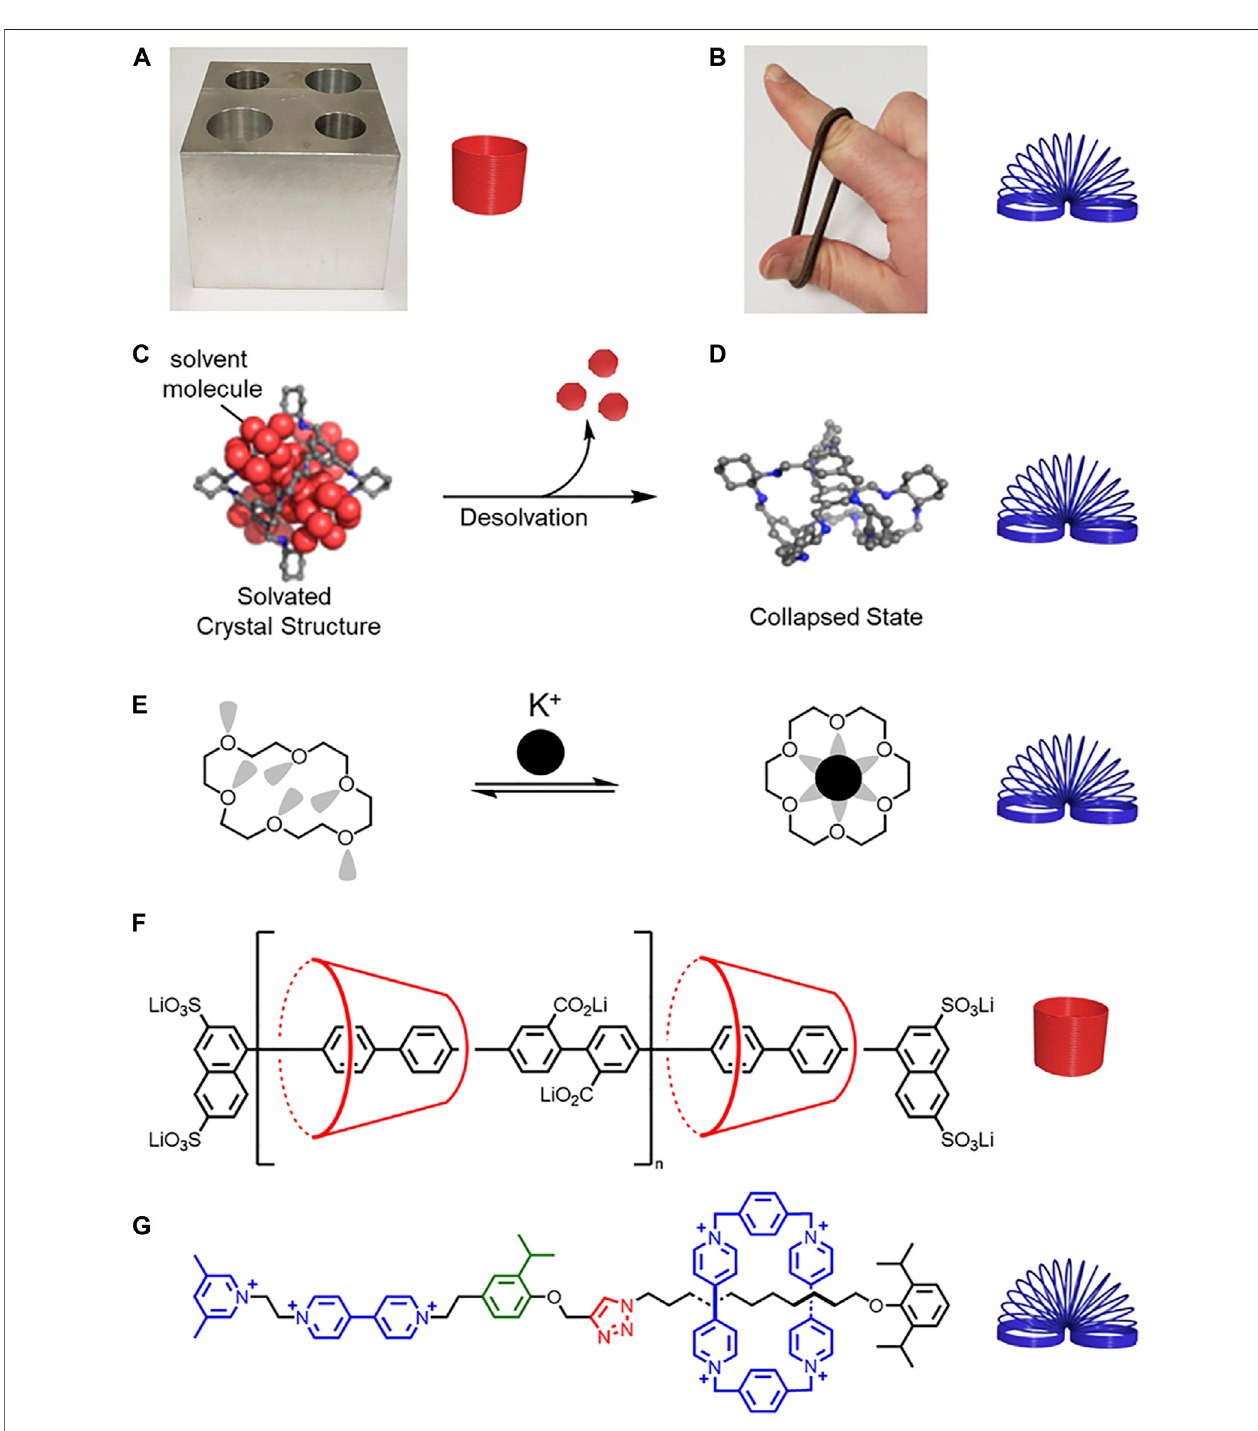
FIGURE 1 | (A) Hard metal block and rigid spring. (B) Soft rubber band and fl exible spring. (C) Schematic representation of a solvated molecular cage (D) collapsing upon desolvation. Adapted with permission from Ref. (Liu et al., 2014). Copyright 2014 American Chemical Society. (E) Structure of a collapsed crown ether that changes shape and rigidi fi es upon potassium complexation. (F) A more rigid polyrotaxane composed of cyclodextrin and a conjugated thread, and (G) a less rigid rotaxane composed of cyclobis (paraquat- p -phenylene) (CBPQT 4+ ) and a thread composed of fl exible alkyl chains and rigid aryl building blocks.